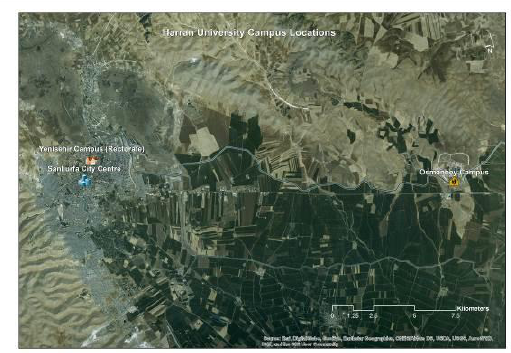
Figure 2. Location of Osmanbey Campus